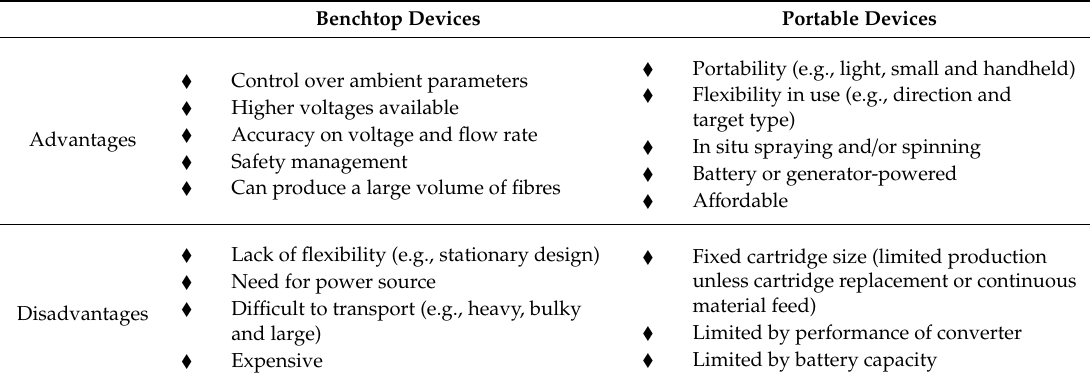
Table 1. Advantages and disadvantages of electrospinning apparatus: comparison between benchtop and portable devices. Adapted from Mouthuy, 2015